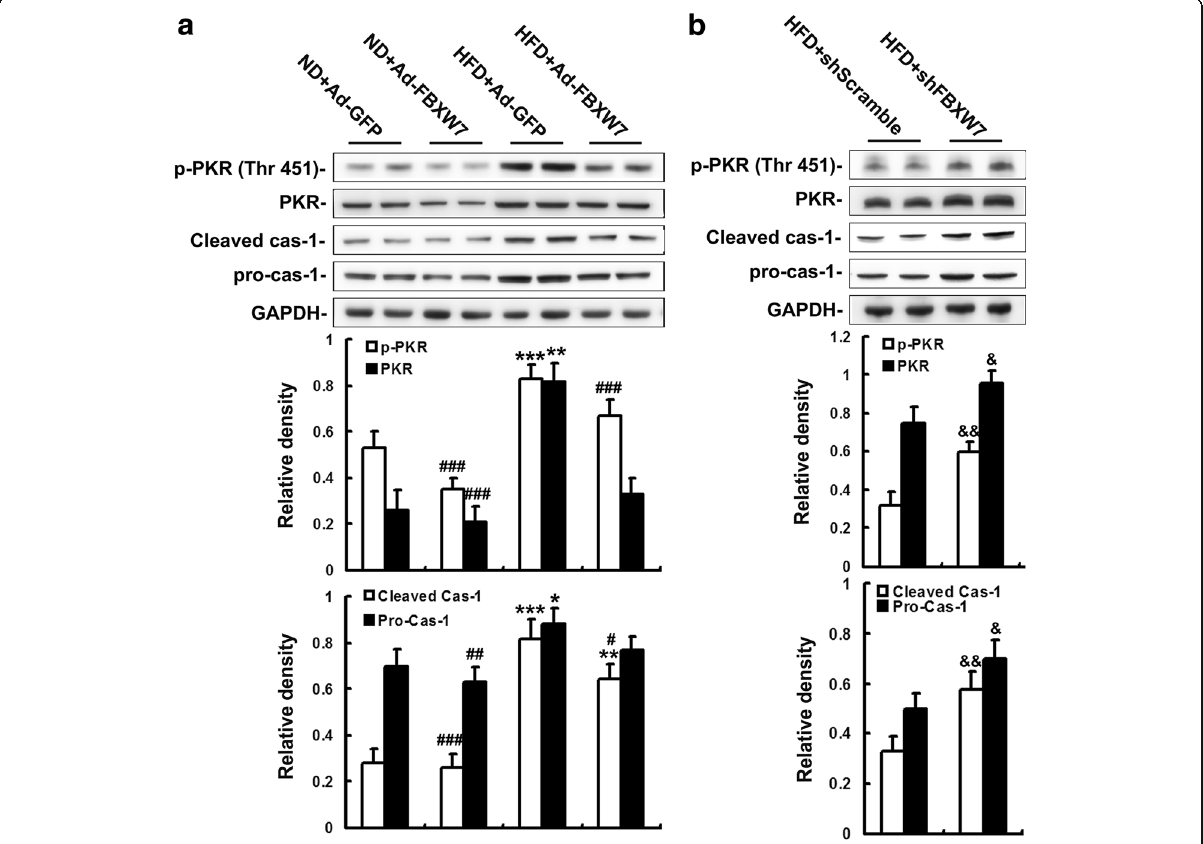
Fig. 5 FBXW7 abates PKR signaling in HFD-fed mouse livers. a and ( b ) Immunoblotting and densitometry of the components of PKR signaling in mouse livers ( n = 4). * P < 0.05, ** P < 0.01, *** P < 0.001 versus the ND + Ad-GFP group; # P < 0.05, ## P < 0.01, ### P < 0.001 versus the HFD + Ad-GFP group; & P < 0.05, && P < 0.01, versus the HFD + shScramble